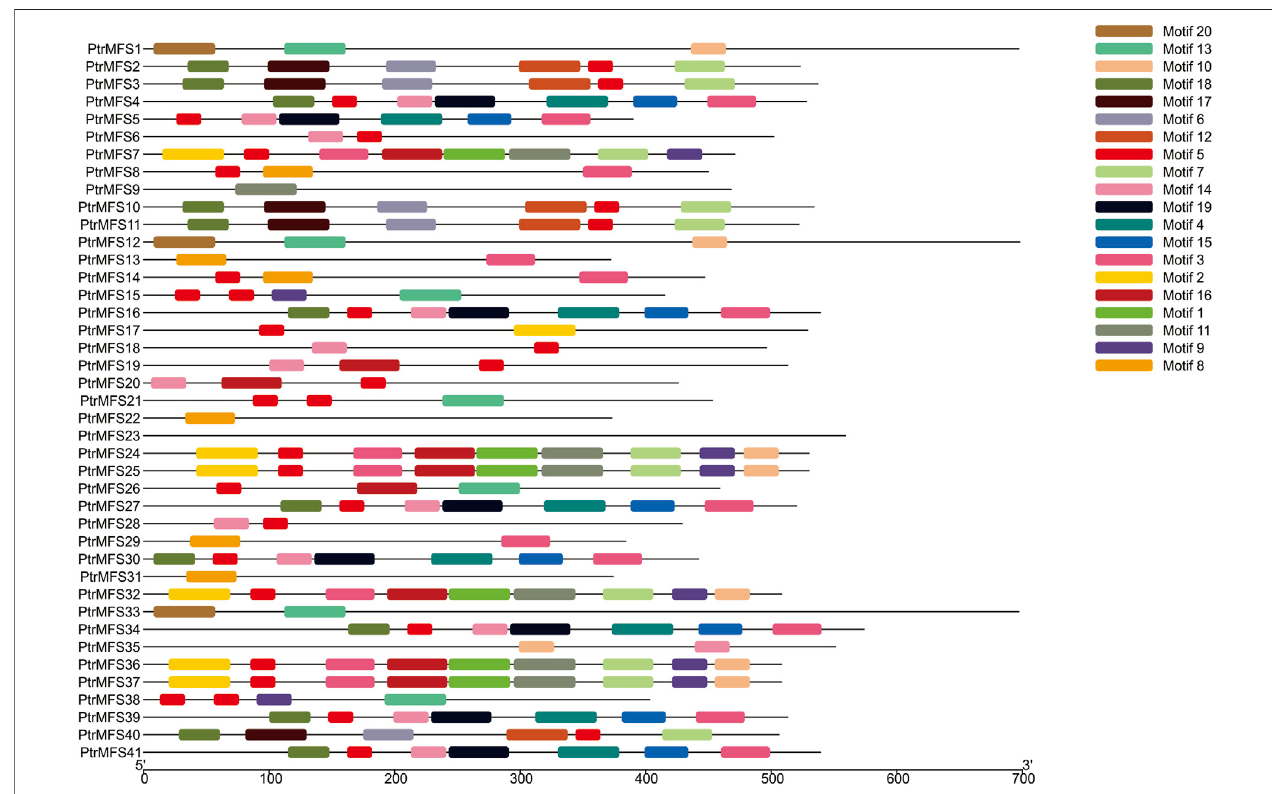
FIGURE 3 | Protein motifs of PtrMFS family in poplar. Different colorful boxes represent different